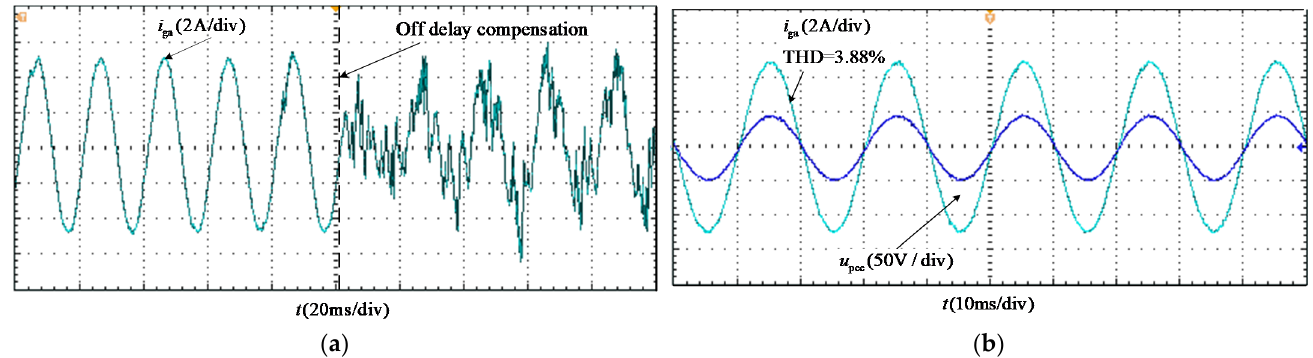
Figure 11. Switching of delay compensation link in weak grid.